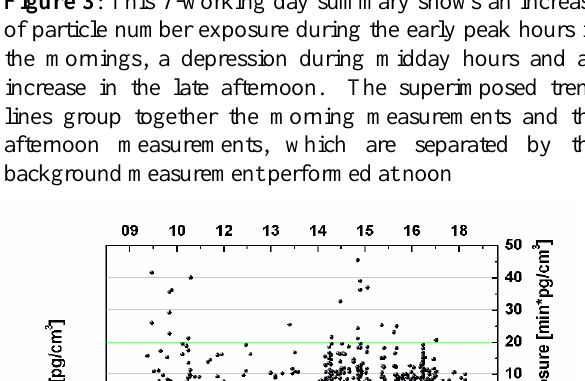
to increasing passenger